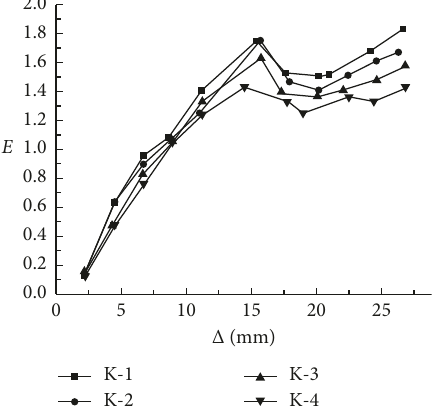
Figure 8: Curves of coefficients of energy dissipation with various concrete strength